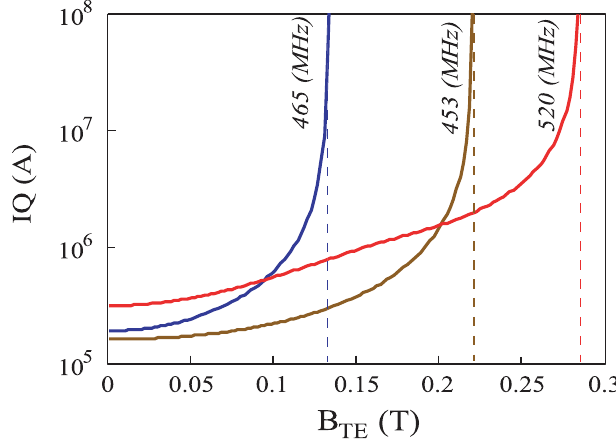
FIG. 9. (Color) Threshold currents of the breakup instability due to the 453, 465, and 520 MHz dipole modes depending on the 1013 MHz TE 021 mode magnetic field